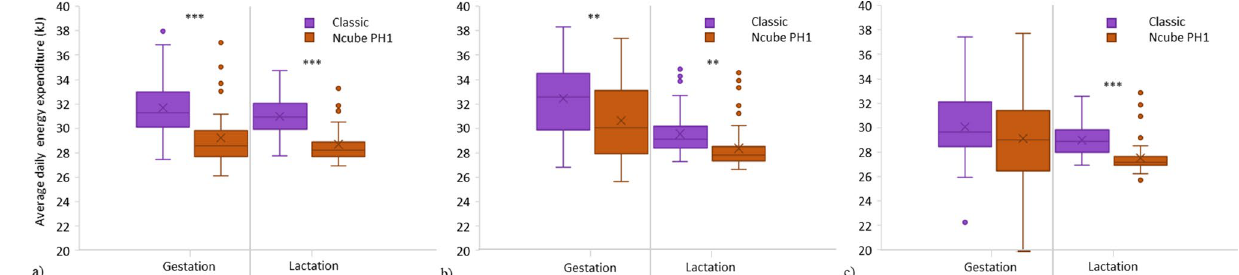
Figure 5. Average daily thermoregulatory energy expenditure (in kilojoules) from bioenergetic modeling for a female bat during the gestation and lactation period in a Classic versus Ncube PH1 bat box on building at: ( a ) cooler, ( b ) intermediate, and ( c ) warmer sites in Quebec, in